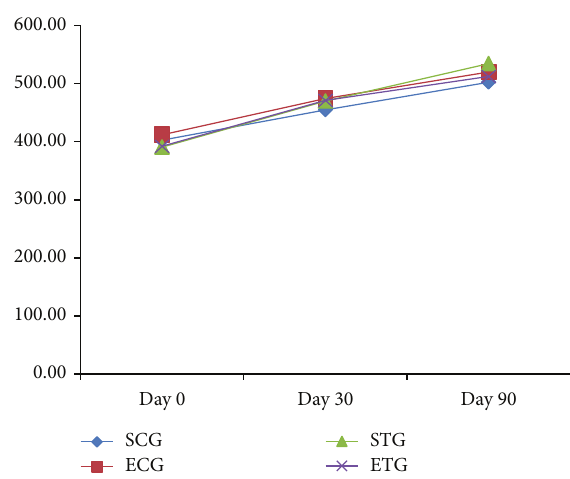
Figure 3: Average body mass gain values (g) of the groups evaluated at days 0, 30, and 90. Different letters in superscript denote significant difference for 𝑃 < 0.05 . Note: SCG: sedentary control group;ECG:exercisedcontrolgroup;STG:sedentarytucum˜agroup; ETG: exercised tucum ˜ a